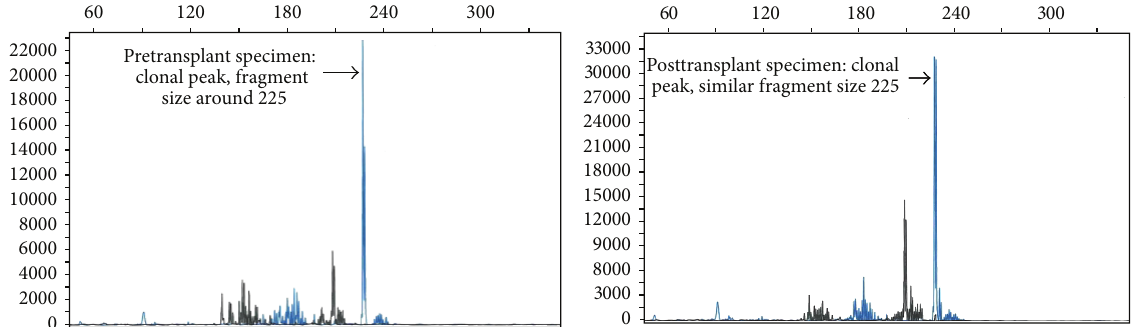
Figure 1: PCR for T-cell gene rearrangement in the pre- and posttransplant skin specimens revealed similar peaks, compatible with the presence of the same clone; 𝑥 -axis shows size of restriction fragment and 𝑦 -axis shows height of